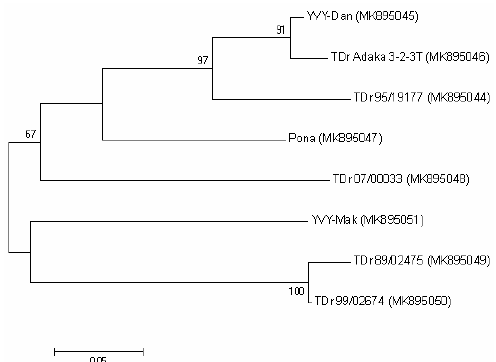
Figure 3. Maximum likelihood phylogenetic tree based on the nucleotide sequences of the CP gene of YVY isolates. GenBank accession numbers are in brackets. These sequences were obtained from